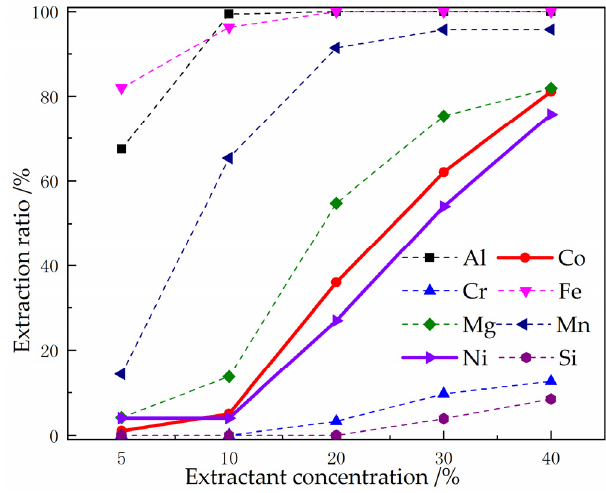
Figure 10. E ff ect of P204 concentration on the extraction of Figure 10. Effect of P204 concentration on the extraction of metals.